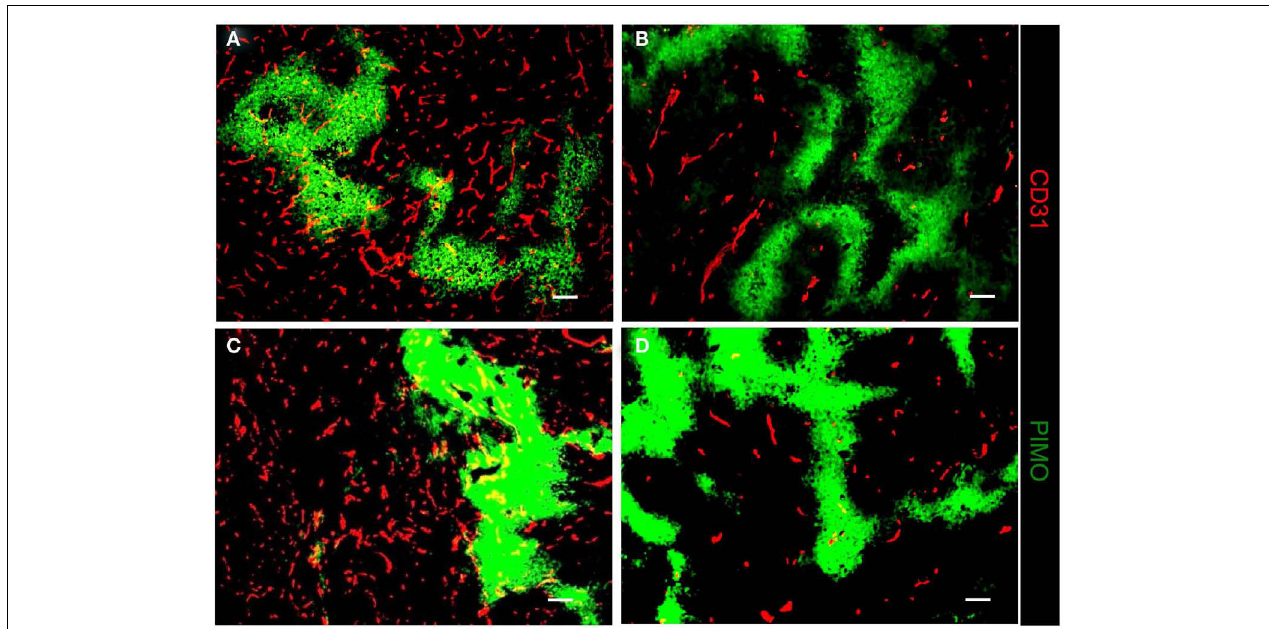
vasculature in the hypoxic regions of irradiated (B) or pre-irradiated tumors (D) . Green: anti-PIMO stain for hypoxic region; red: anti-CD31 antibody for vessels. Merged images: the colocalization of hypoxia and vessels. Scale bar = 100 µ m.